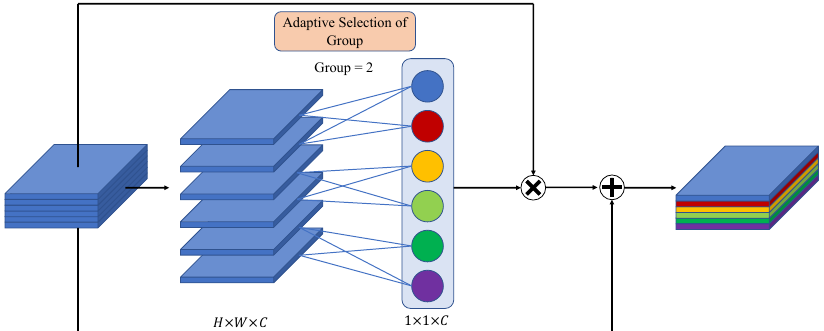
Figure 6. Structure of our proposed